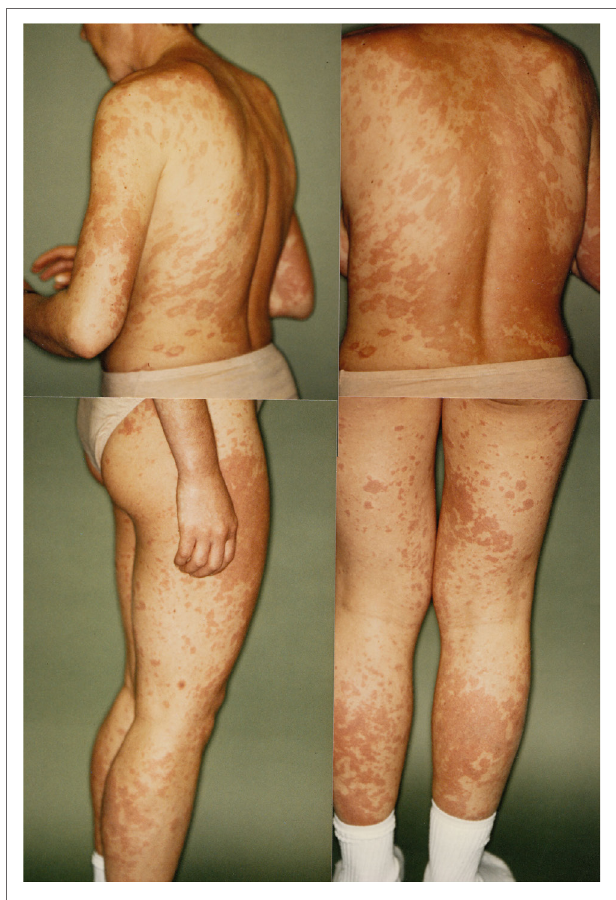
FIGURe 1 | Skin manifestations of the patient in April 1993, hypothesized as Stevens–Johnson